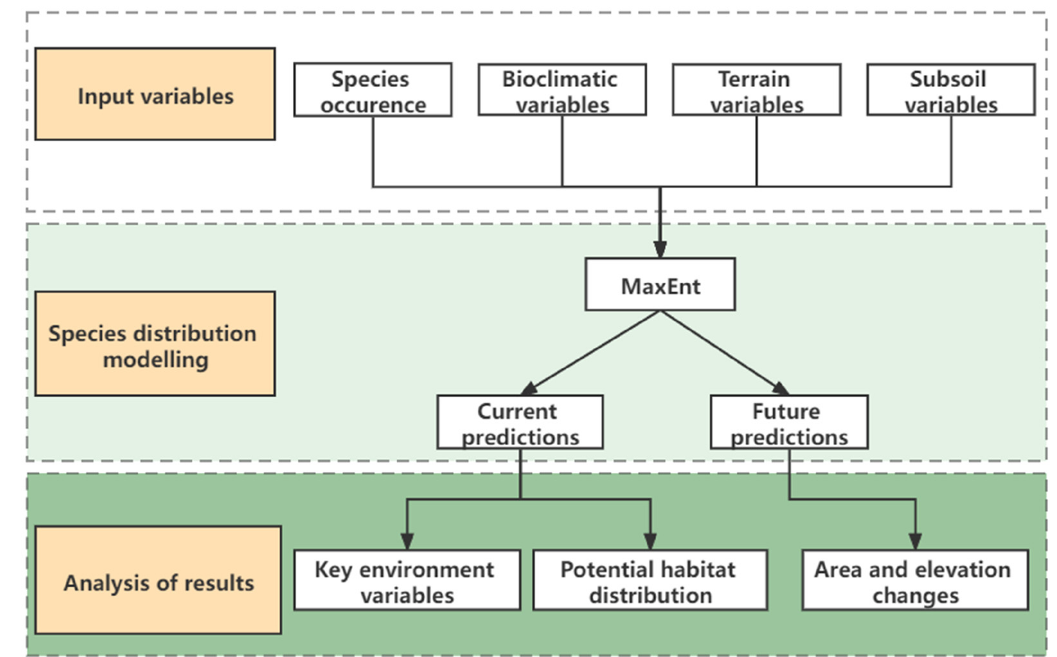
Figure 2. Flow diagram of methodology adopted.